Question: Name the type of graph shown.
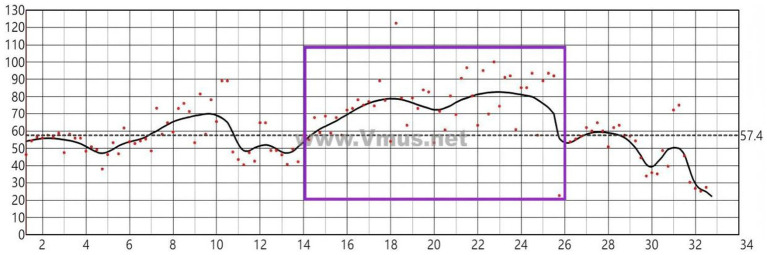
Answer: line